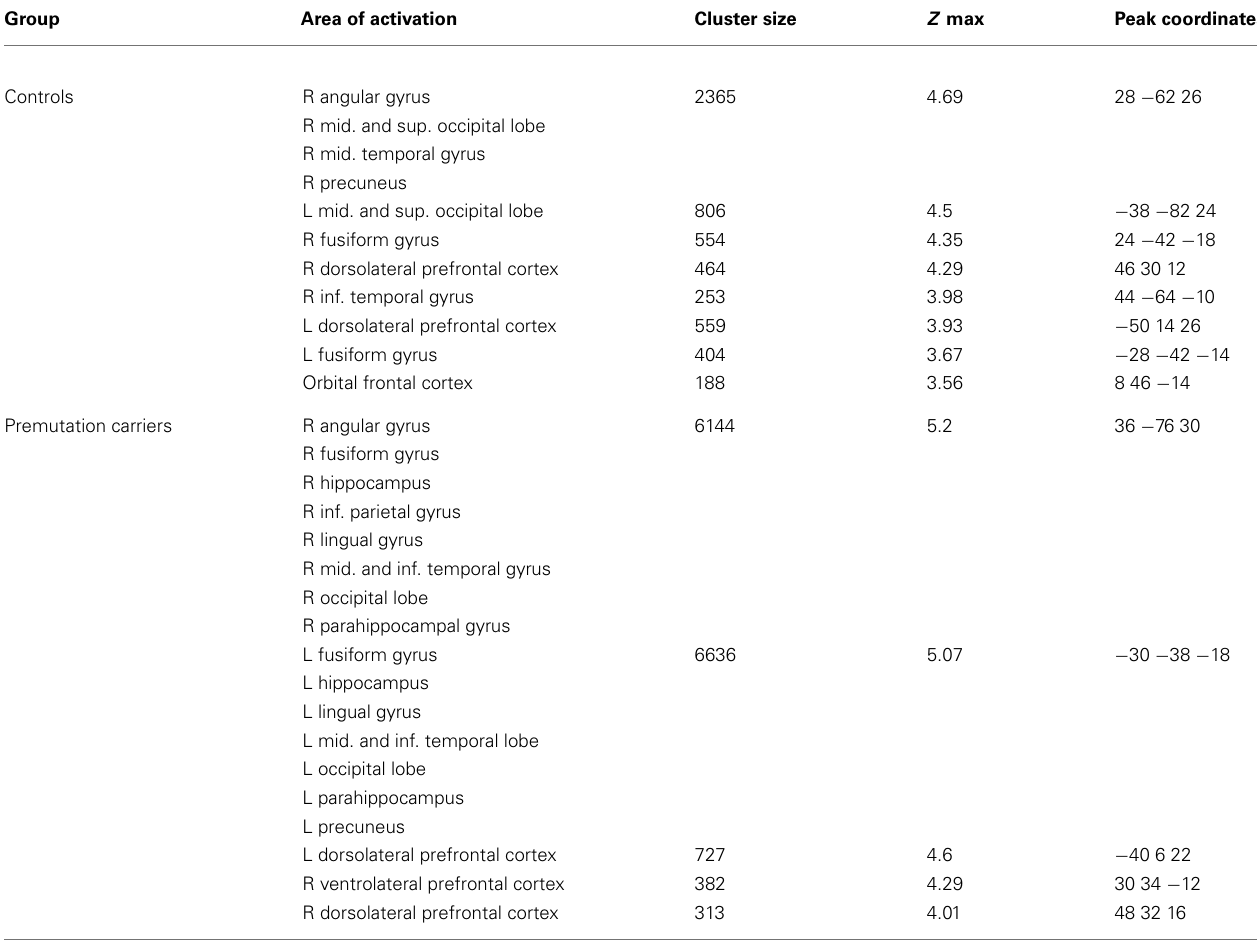
Table 4 |Within-group activation data for both premutation carriers and control group on the whole-brain level for the correctly recalled > incorrectly recalled